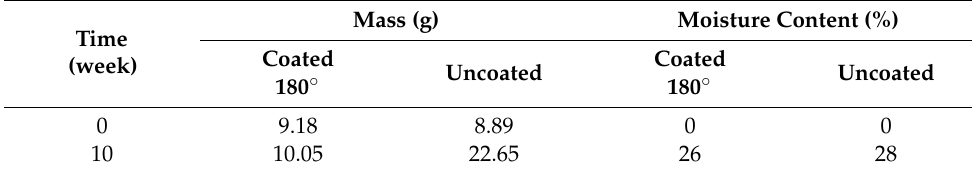
Table 6. Durability test result on bamboo samples with silica–TMCS coating.